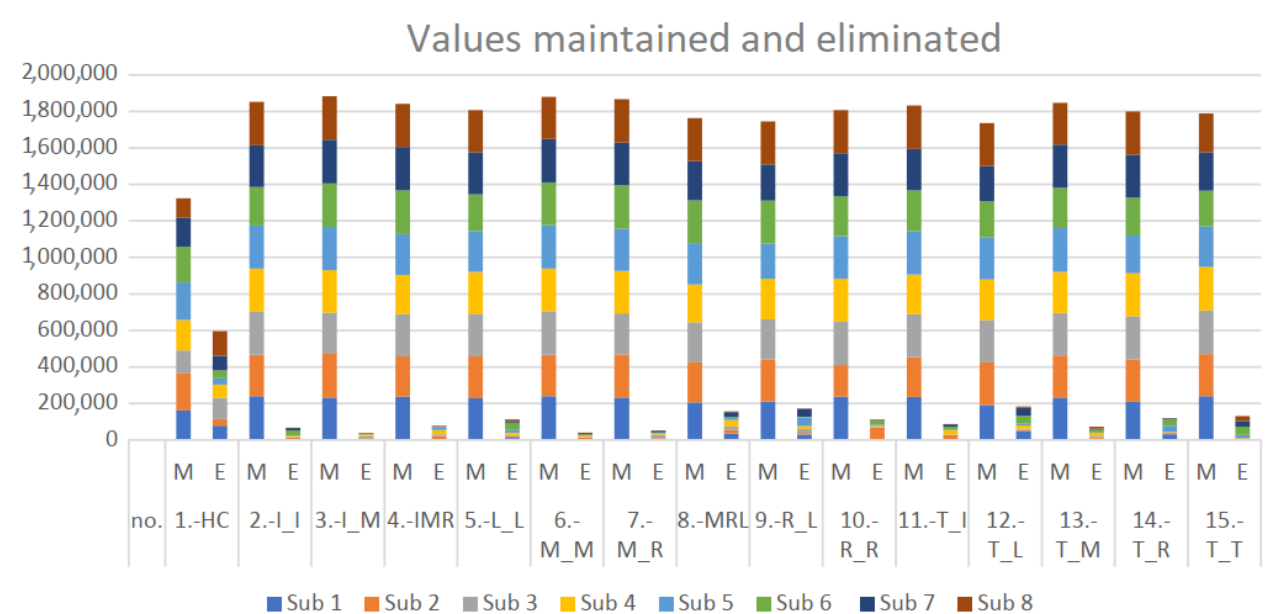
Figure 8. Outliers maintained and eliminated. M = maintained, E = eliminated. The total data for the 8 subjects (sub #, subject number) in the 15 movements are displayed.